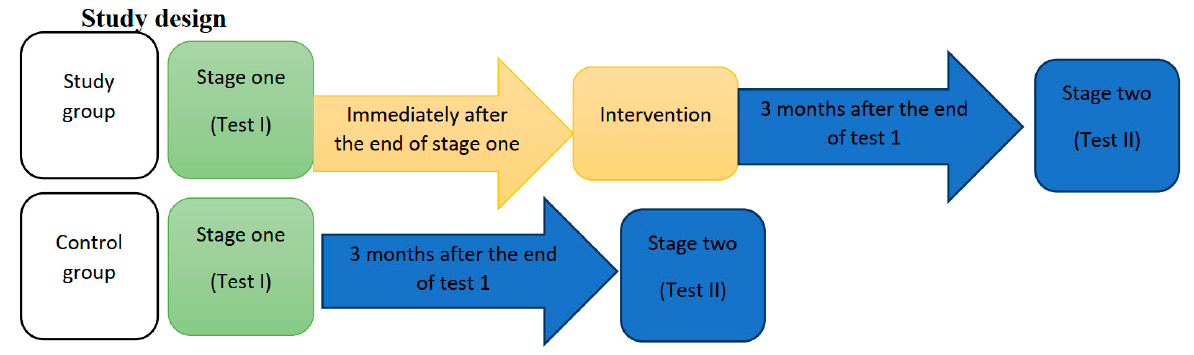
Figure 4. Study Design.